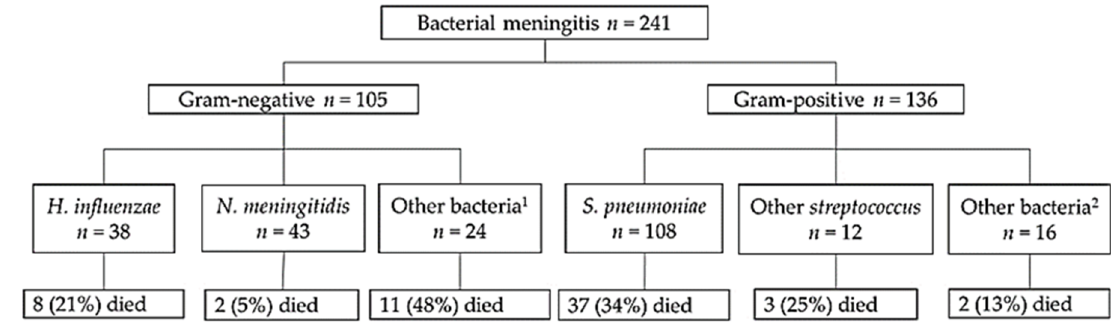
Figure 1. Distribution of the pathogens in the study population. 1 Salmonella spp. ( n = 5), Proteus spp. ( n = 6), Citrobacter freundii ( n = 2), Escherichia coli ( n = 2), Klebsiella spp. ( n = 6), Shigella spp. ( n = 1), Enterobacter spp. ( n = 1), and unknown Gram-negative bacteria ( n = 1). 2 Staphylococcus aureus ( n = 3) and unknown Gram-positive bacteria ( n = 13).